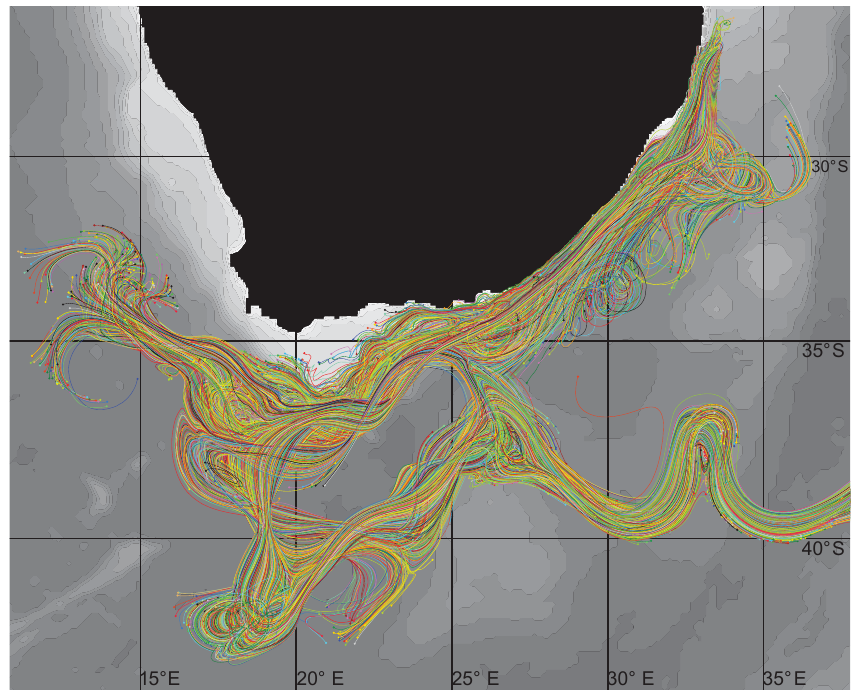
Figure 5. Agulhas trajectories started evenly distributed in a square of four grid cells and followed for 50 days. Colouring is used to separate the trajectories from each other. Table 1. The table shows the average distance between the time-dependent integrated trajectories and the stepwise-stationary integrated ones at the end of simulations, which is 50 days for the OGCM and 10 days for the AGCM. I S is the number of intermediate time steps between two GCM outputs. The “maximum time step” stands for the intermediate time step lengths ((cid:49)t i ) , which are used in the different trajectory integrations. The last column is the computational time normalised with regard to the time-dependent case, where theoretical velocity fields are used to compute trajectories, i.e. with no data reading or writing. Distance to time dependent T L Maximum time step Normalised OGCM AGCM AGCM OGCM OGCM computational I S (km) (km) (days)